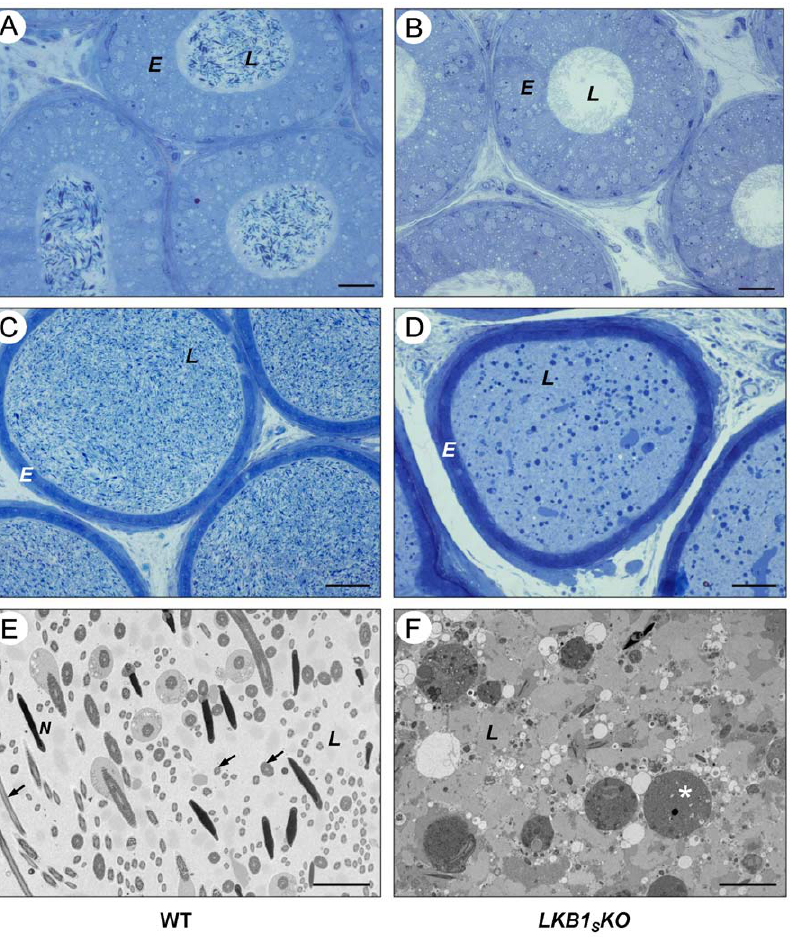
Figure 3. Histology of the cauda and caput epididymis. Cauda epididymis ( A – B ) and caput epididymis ( C – D ) sections were visualised by light microscopy. Representative images are shown from observations of three mice per genotype. Epididymal epithelia (E) and tubule lumens (L) are labelled. ( A ) and ( C ) show sections through wild-type epididymis showing an abundance of spermatozoa within the lumen. ( B ) and ( D ) show sections through the epididymis of LKB1 S KO mice showing abnormal structures within the lumen and very few spermatozoa. ( E – F ) TEM images of the cauda epididymal lumen from a wild-type mouse ( E ) and a LKB1 S KO mouse ( F ). The wild-type section shows numerous cross-sections through sperm heads ( N ) and tails ( arrows ). The section from a LKB1 S KO mouse shows dense luminal fluid (as indicated by the darker background to WT), cellular debris, abnormal round structures ( asterisk ) and an absence of recognisable spermatozoa cross sections (A and B, scale bar =20 m m; C and D, scale bar =50 m m; E and F, scale bar =5 m